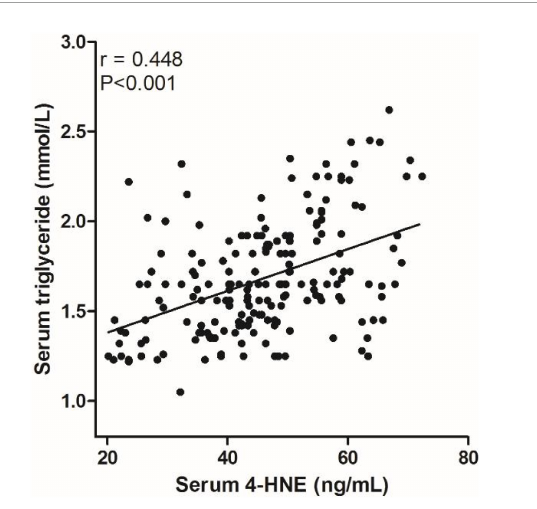
FIGURE1 Comparison of serum 4-hydroxynonenal (4-HNE) level between non-recurrence group and recurrence group.